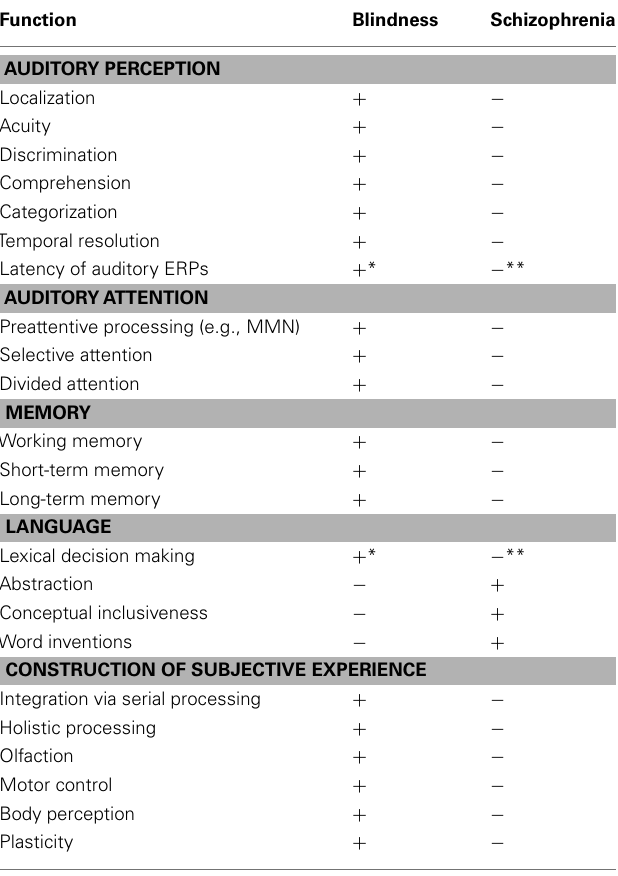
Table 1 | Summary of cognitive and brain function enhancements ( + ) and impairments ( − ), compared to healthy sighted individuals, in C/E blindness and